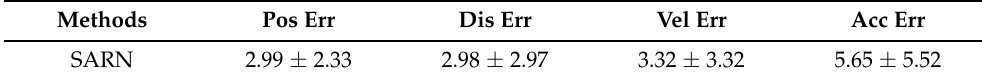
Table 6. Performance on PAKH Dataset (mean ± std). Methods